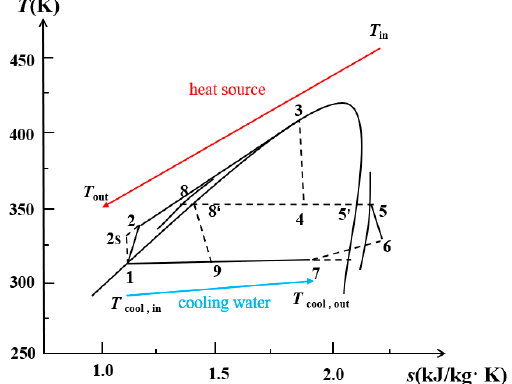
Figure 2. The T-S diagram of mixtures in the OFC system.